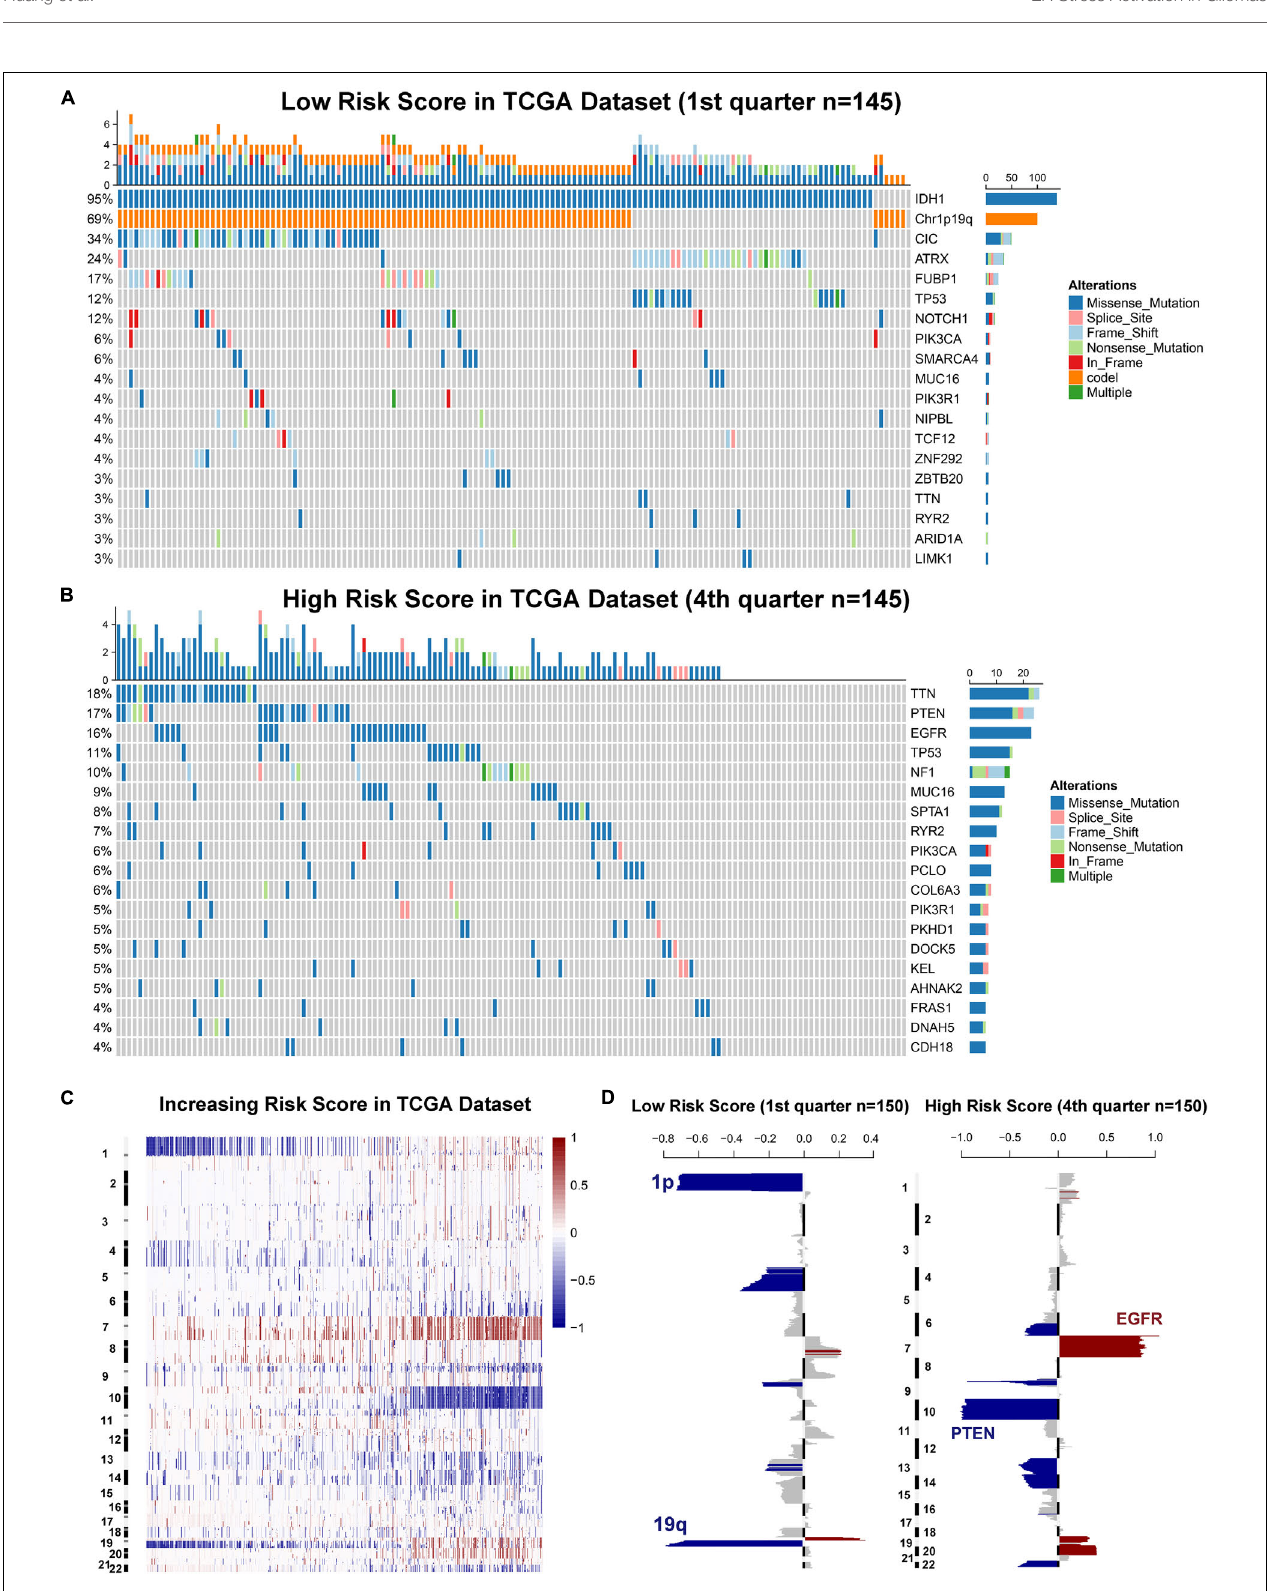
FIGURE 3 | Gliomas with different ER stress activation status have distinct genomic profiles. (A,B) Distinct somatic mutations identified by comparing gliomas with low- and high-risk score. (C) CNV profiles with increasing order of the risk score of ER stress-related signature. (D) A distinct CNV spectrum defined by risk scores of ER stress-related signature. The amplification (red) and deletion (blue) of chromosome segment are presented.